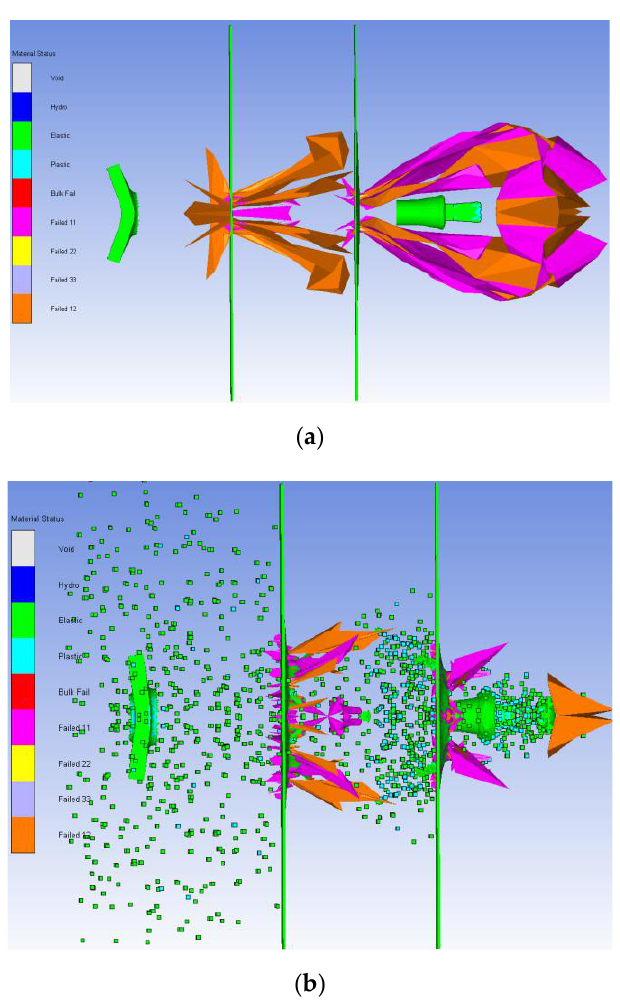
Figure 9. Result of damage caused by warheads to double-layer target plates at different impact velocities: ( a ) v 0 = 800 m/s and ( b ) v 0 = 1400 m/s.